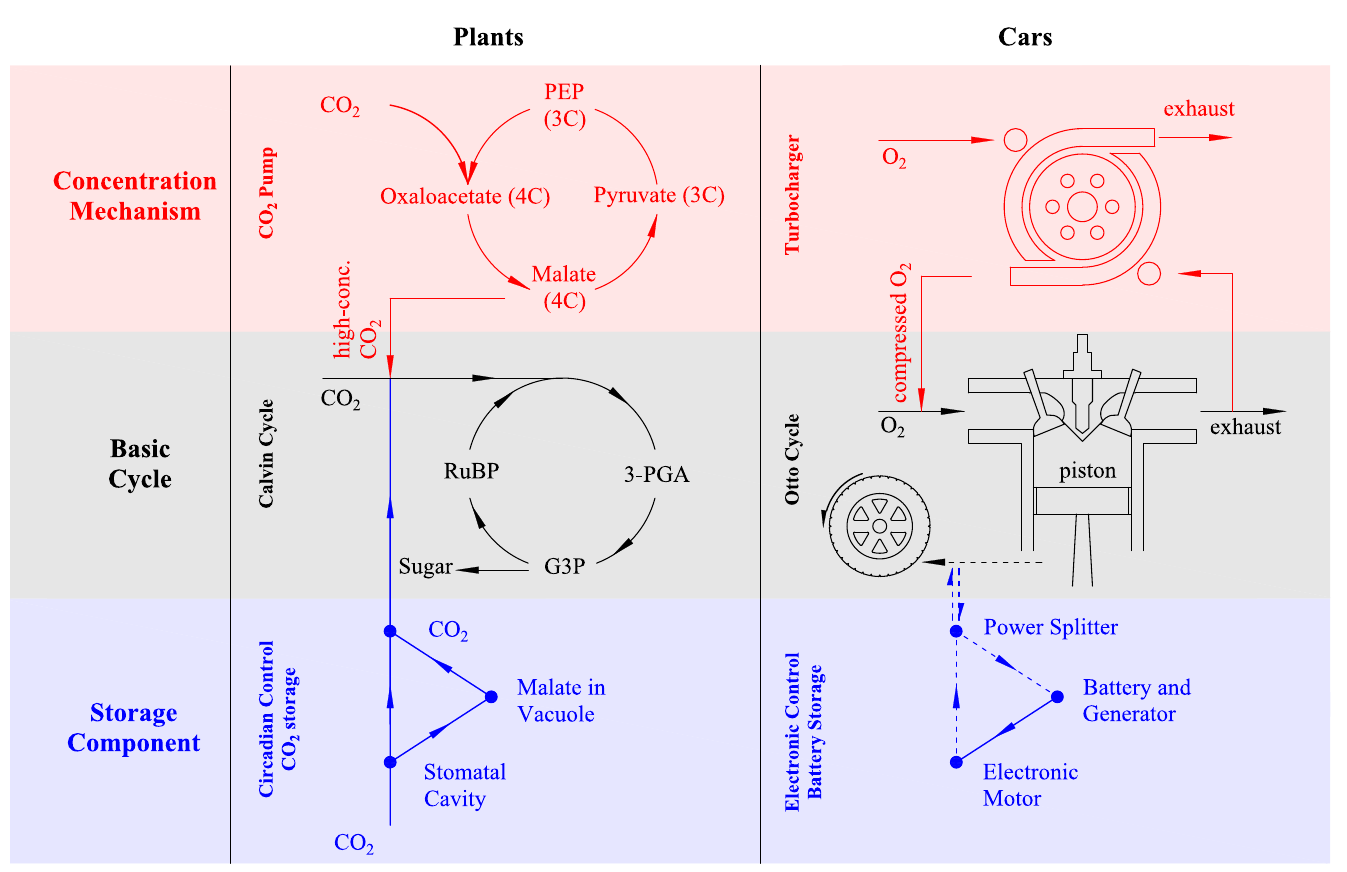
Fig 2. A comparison of plant photosynthesis and car engine functioning illustrates how the core processes interact with the additional components. The core processes in each system are the Calvin cycle and the ICE (middle row). A concentrating mechanism in C4 plants and turbocharged cars provides concentrated CO 2 and oxygen, respectively, to the core cycle (upper row). A storage mechanism in CAM plants allows carbon dioxide to be stored as malic acid at night and then passed to the Calvin cycle during the day, while a storage mechanism in HEVs allows energy to be stored in the battery during braking and then passed to the motor to power the drivetrain in parallel with the engine (bottom